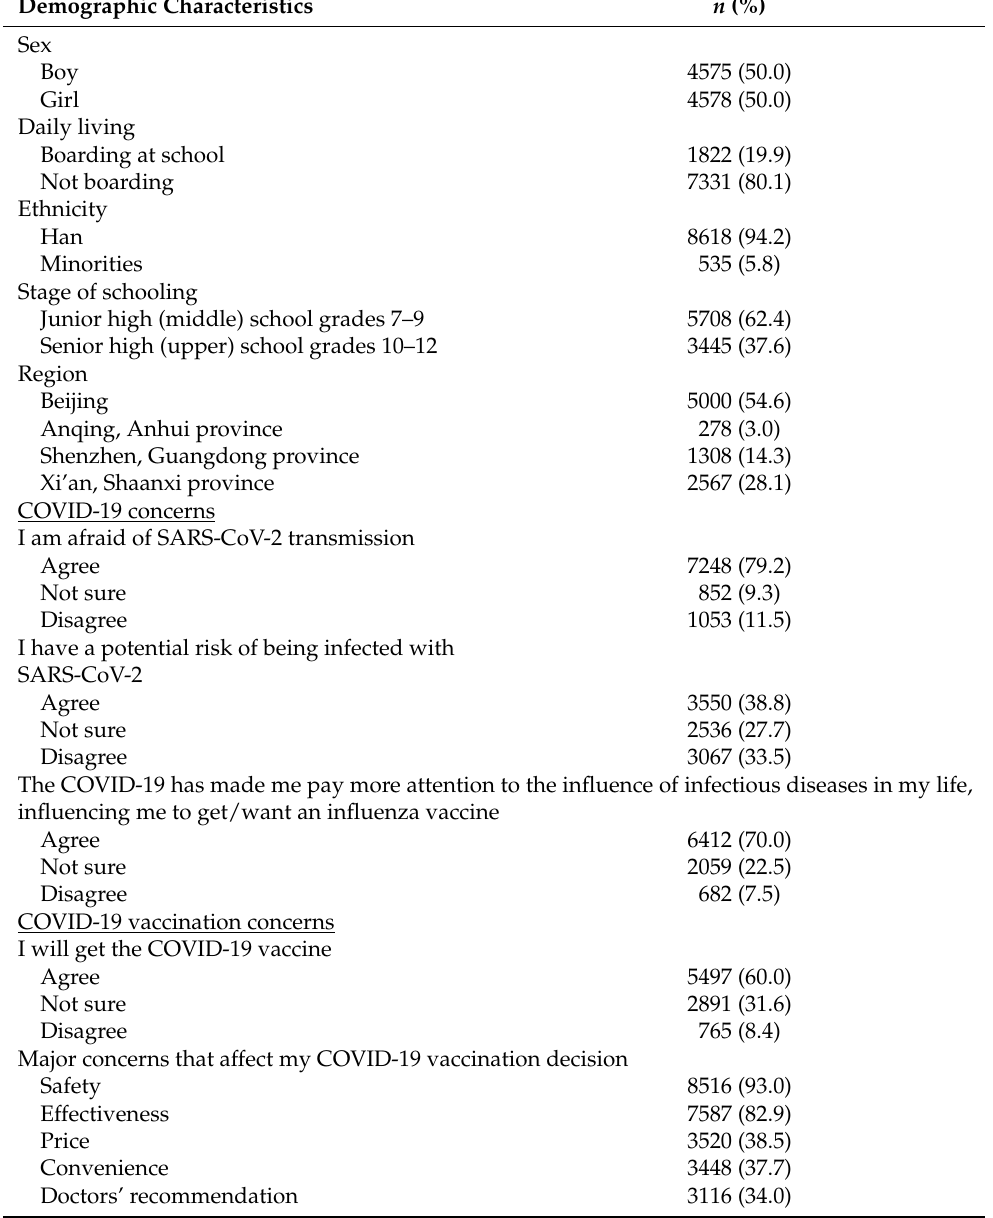
Table 1. Demographic characteristics and COVID-19 vaccination concerns of school students in grades 7–12 in four cities in China (N =